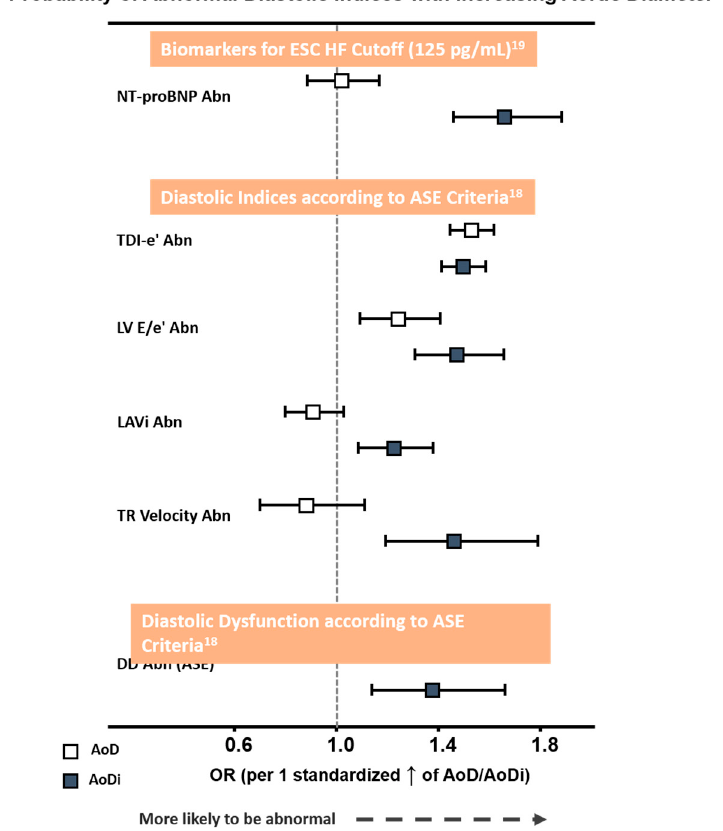
Figure 3. Probability of abnormal NT-proBNP by ESC HF cut-off (>125 pg/mL) and diastolic functional indices proposed by ASE criteria with larger AoD and AoDi. The odds ratio (OR) was 1.44/1.50 for LV septal e’ and lateral e’, both p < 0.001. Abbreviations as in Table 2. Abn: abnormality; AoD: aortic root diameter; AoDi: indexed aortic root diameter; E/e’: averaged early mitral inflow E to mitral annulus relaxation velocity e’ ratio; TDI-e’: averaged peak mitral annulus relaxation velocity e’; LAVi: left atrial volume index; Nt-ProBNP: N-terminal pro-brain B-type natriuretic peptide.